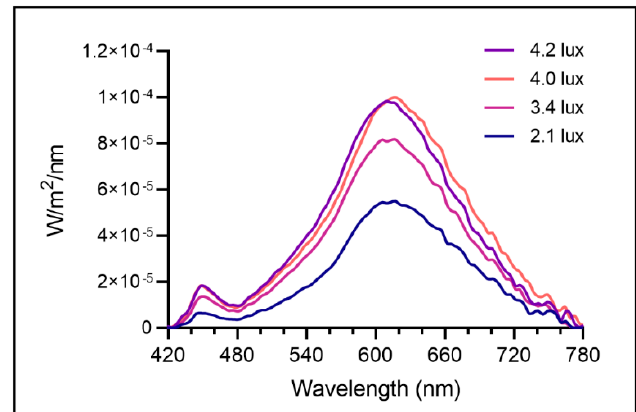
Figure A2. The spectral power distribution across wavelengths of the LED light source used for ALAN 5 lux illumination. Illuminances were measured in different directions on the position of the volunteer’s head during sleeping. Peak wavelength ~610 nm. Measured with spectrophotometer CL-500A (Konica Minolta Sensing Europe BV, Germany).